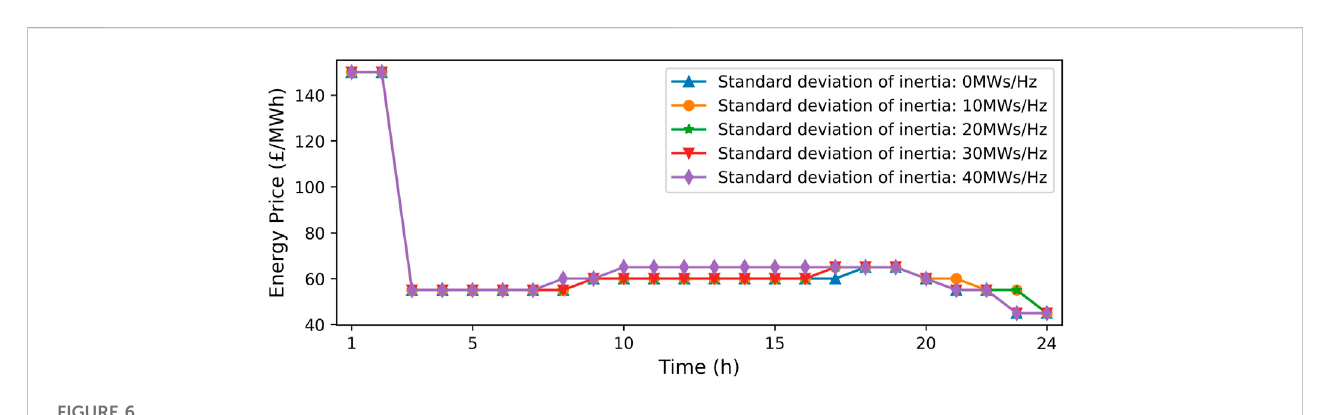
FIGURE 6 Impact of the standard deviation of inertia on energy